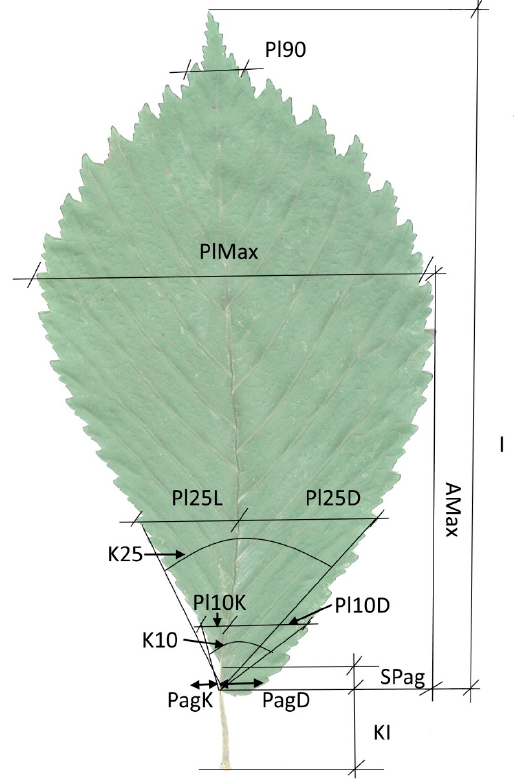
Figure 2. The leaf blade measured traits. The abbreviations are explained in Table 2 (No. 3–16). Table 2. Results of ANOVA on the effect of species on the leaf morphology traits of elms and their hybrids. No. is a numeric ID of a trait. The model R 2 , F value, and Pr > F from ANOVA are given for n = 189 individuals.